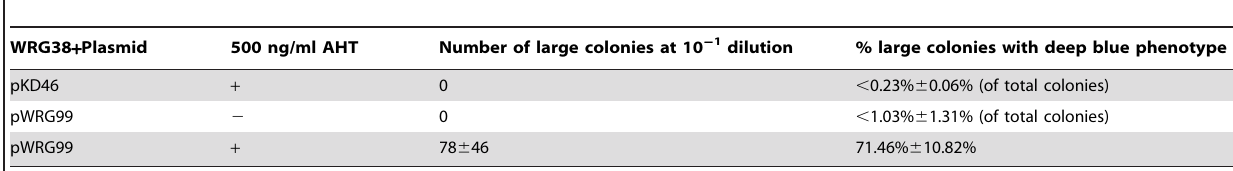
Table 2. Quantification of colonies with constitutive active PhoP phenotype after recombination.